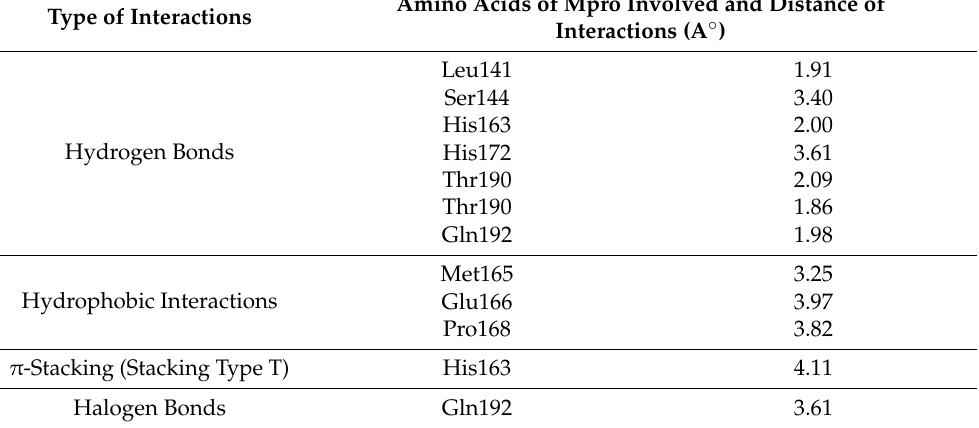
Table 3. Interactions of amino acid residues with EXP3174 at receptor sites of MPro and RBD of S protein of SARS-CoV-2 using PLIP. Binding energies and affinity constants should be viewed in relative terms—they highlight differences between ligands and do not account for entropy